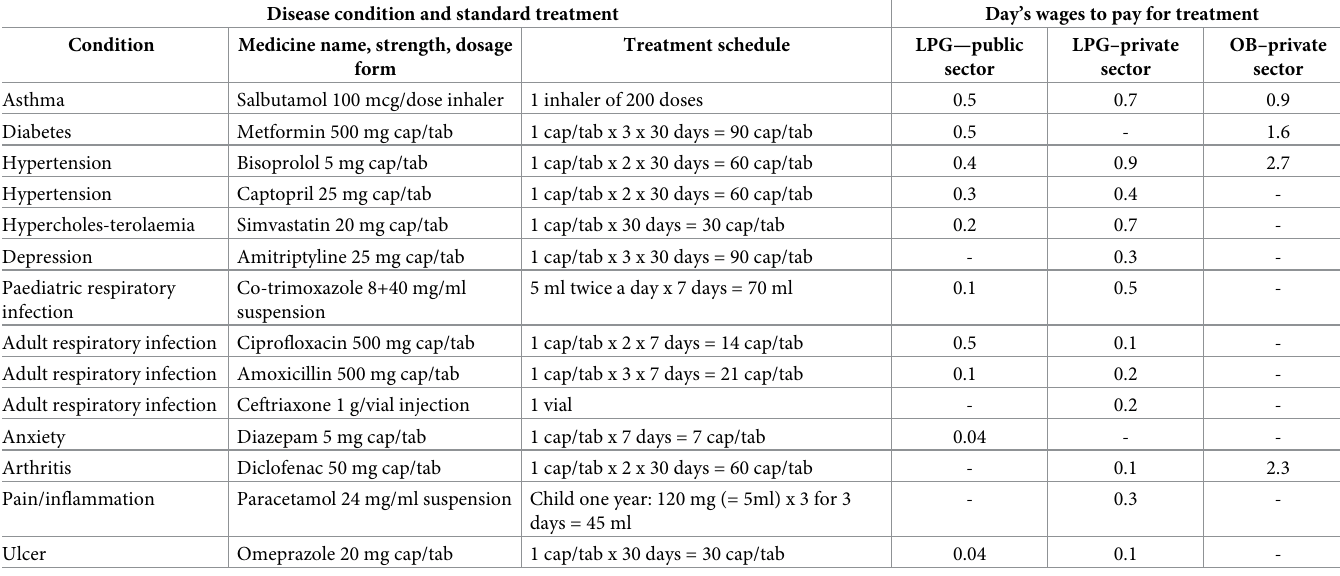
Table 6. Number of days’ wages of the lowest-paid government worker needed to purchase standard treatments. Disease condition and standard